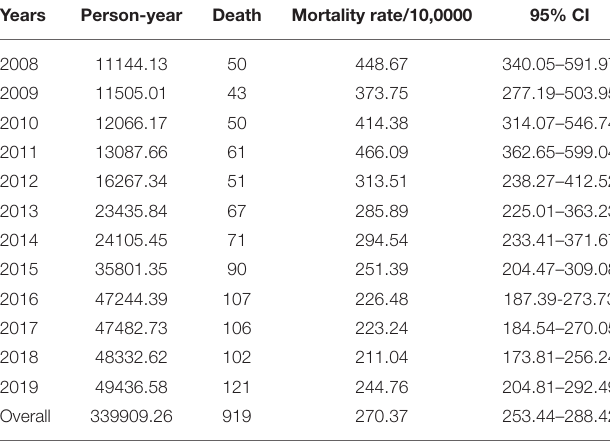
TABLE 1 | Socio-demographic characteristics of all reproductive age and deceased women under the Kersa Health Demographic Surveillance System, Eastern Ethiopia from 2008 to 2019.